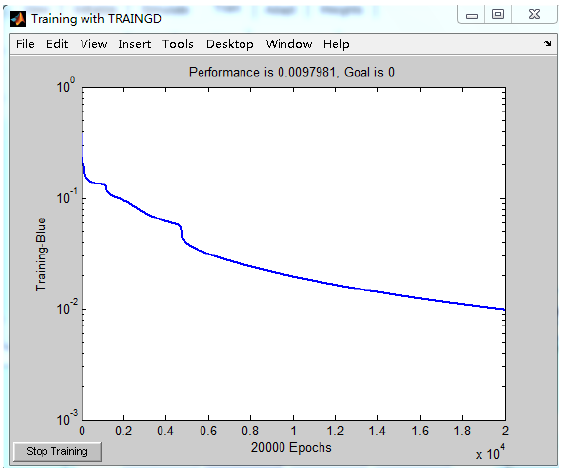
Figure 10. The training process based on the traditional algorithm.